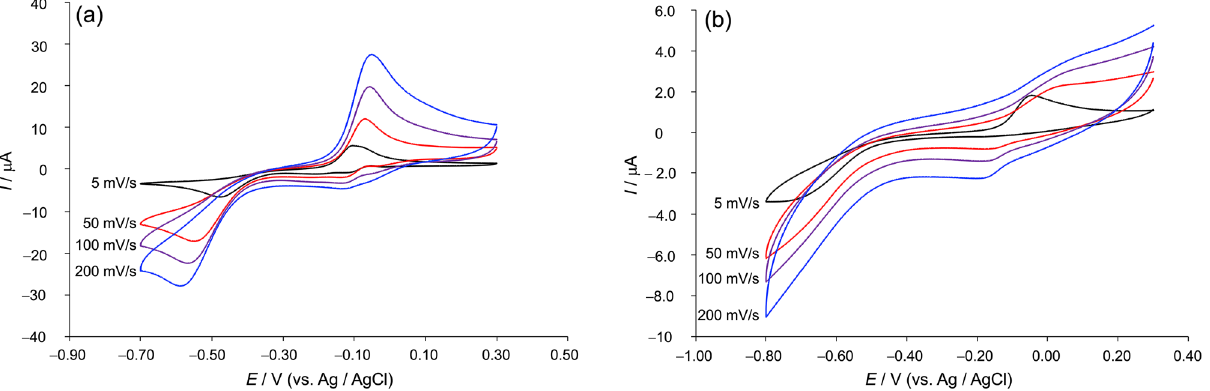
Figure 7. Cyclic voltammograms of ( a ) CuST-Imi (1.0 mM) and ( b ) CuST@lysozyme (CuST 1.0 mM + lysozyme 2.0 mM) at various sweep rates (5−200 mV/s). All voltammograms were measured in 0.1 M phosphate buffer (pH 7.0). Glassy carbon, Pt-wire, and Ag/AgCl electrodes were used as the working, counter, and reference electrodes,